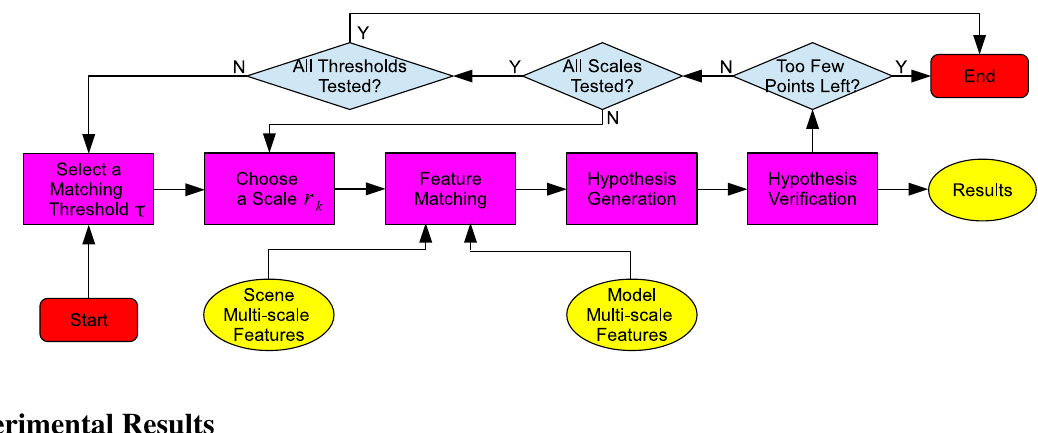
Figure 5. Coarse-to-fine object recognition algorithm (figure best seen in